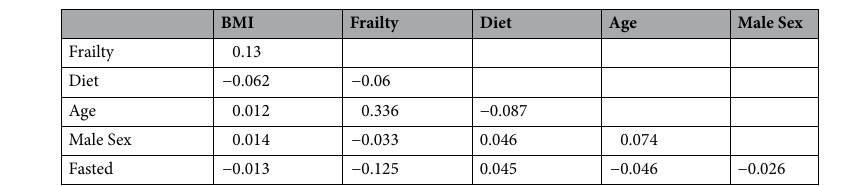
Table 4. Rho coefficients of correlation between participant characteristics. Significantly correlated factors were frailty and age ( p = 2.2e−16), frailty and fasting status ( p = 0.001), frailty and BMI ( p = 0.0007), BMI and having fasted prior to sample collection ( p = 0.001), and diet and age ( p =